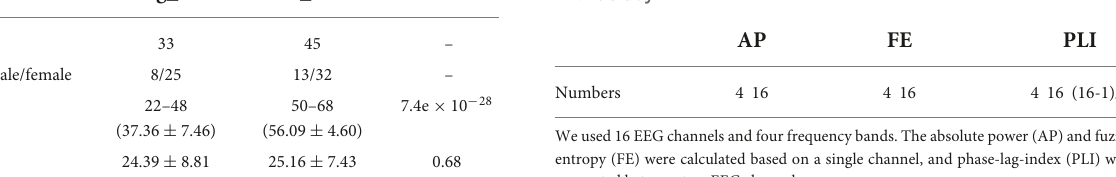
TABLE 1 Demographic and clinical characteristics of the participants.